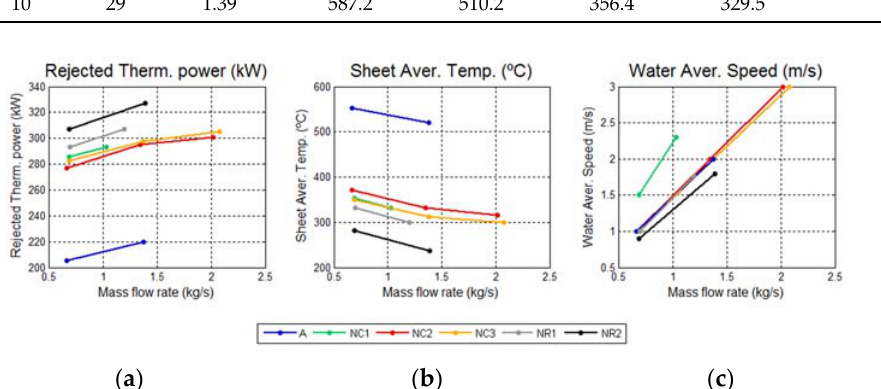
Figure 11. ( a ) Port design comparison: cooling thermal power; ( b ) upper plate average temperature; Figure 10. ( a ) Detailed model results: water speed; ( b ) cooling water temperature; ( c ) metal temperature. ( c ) cooling water average speed. The main results for the original design (A) and for different proposed configurations Table 1. Port design comparison. (rounded NC and non ‐ rounded NR) are shown in Table 1 and Figure 11.